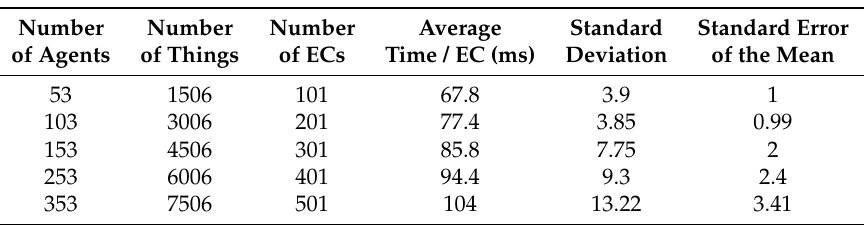
Table 3. The results of case 1 experiment.